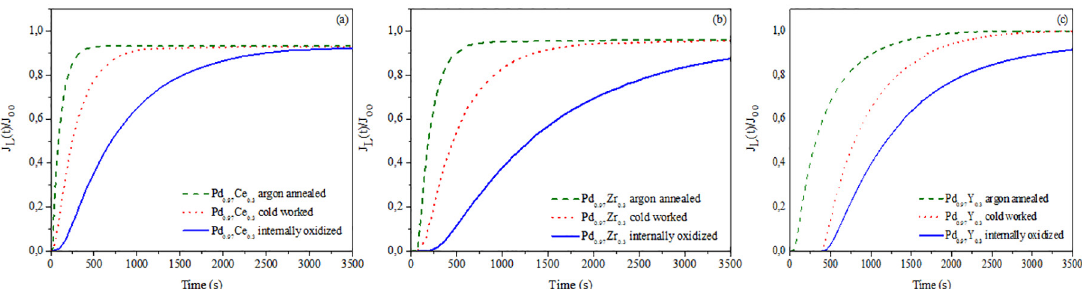
Ce (a); Pd Zr (b) and Pd 0.97 0.03 0.97 0.03